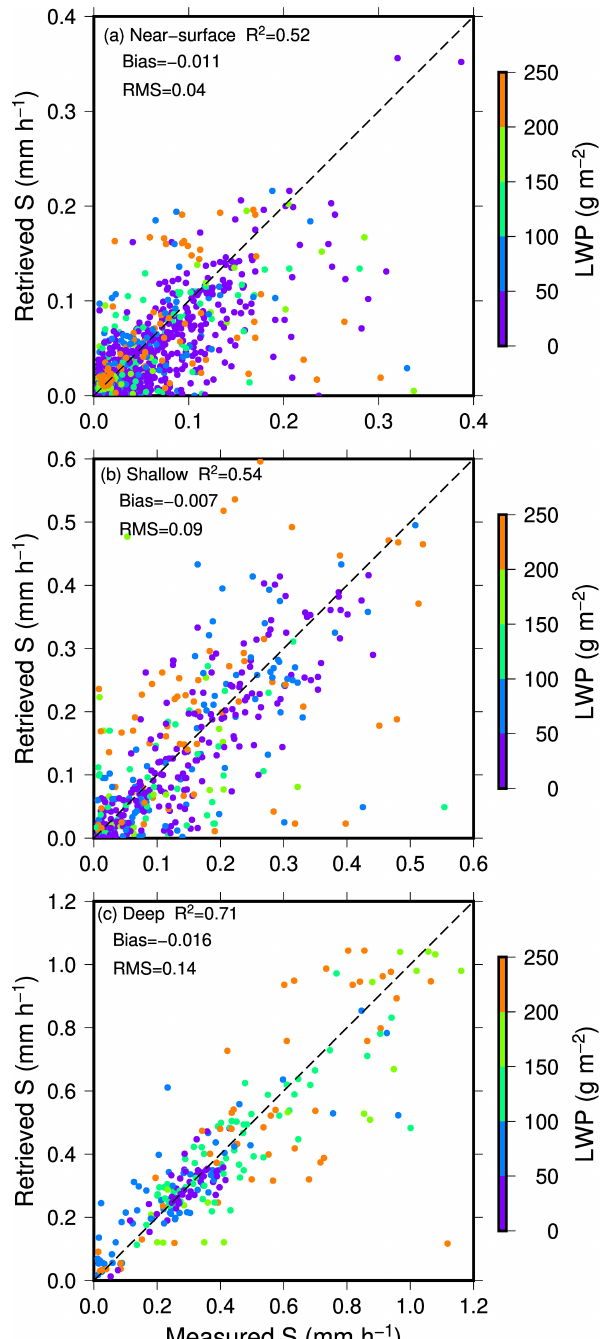
Figure 13. Scatterplot of measured versus retrieved snowfall rates for (a) near-surface, (b) shallow, and (c) deep snow clouds over ocean. The color of the points indicates the liquid water path as- sociated with the case. The correlation is indicated by R 2 in each diagram. Biases and root mean square (RMS) differences are also indicated in the diagrams.